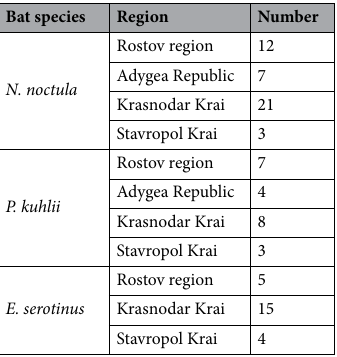
Table 2. Table representing bat species, their areal, and number included in the